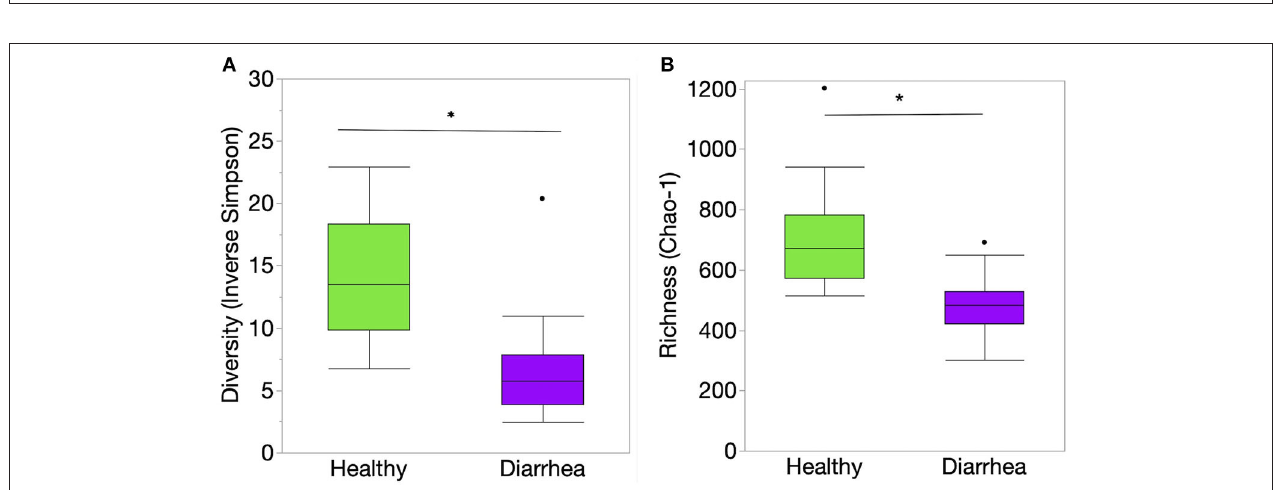
FIGURE 1 | Venous blood ph (A) and anion gap (AG) concentration (B) of healthy ( n = 20) and diarrheic ( n = 31) calves. The AG was calculated using the following formula: AG = (Na + K) – (Cl + HCO −